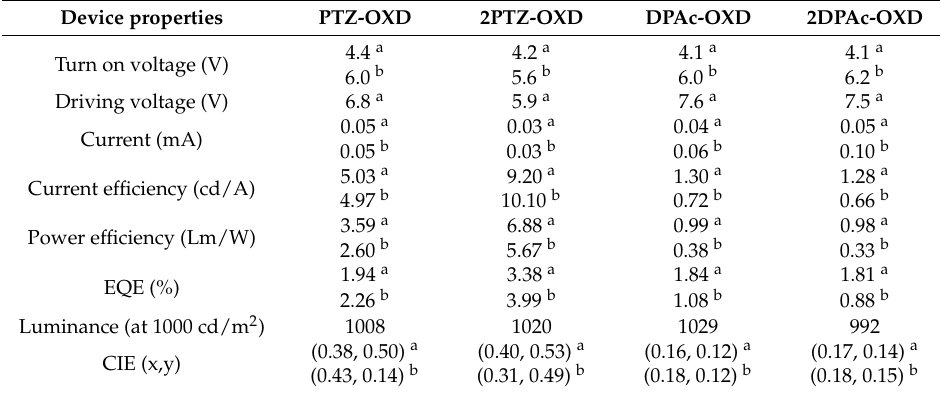
Figure 5. Current density-voltage-luminance ( J-V-L ) and luminescence -current and power efficiency of the fabricated Devices 1 and 2. Table 3. Device characteristics of fluorescent emitters PTZ-OXD, 2PTZ-OXD, DPAc-OXD and